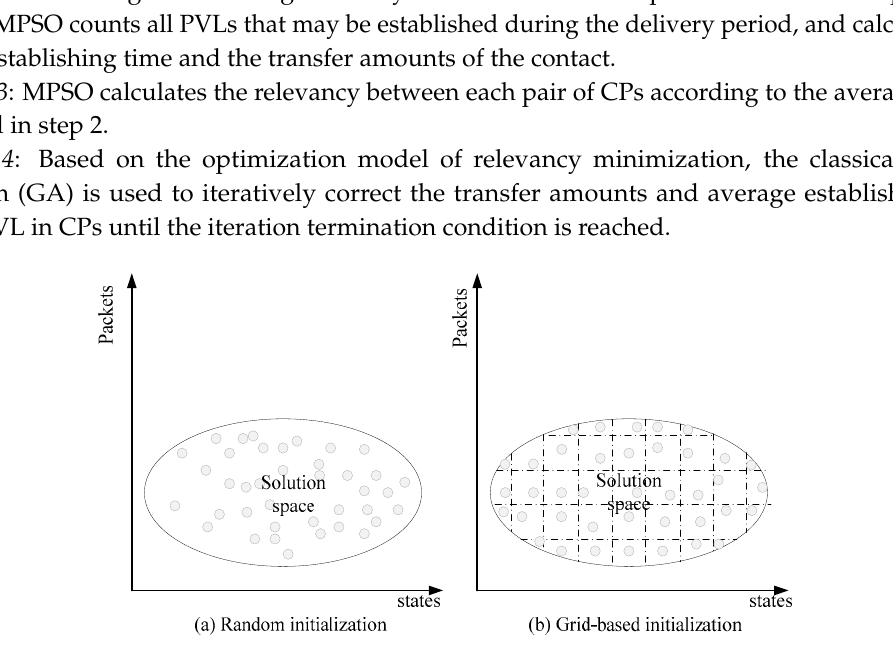
Figure 5. Random initialization and Grid-based initialization with two dimensions in MPSO.